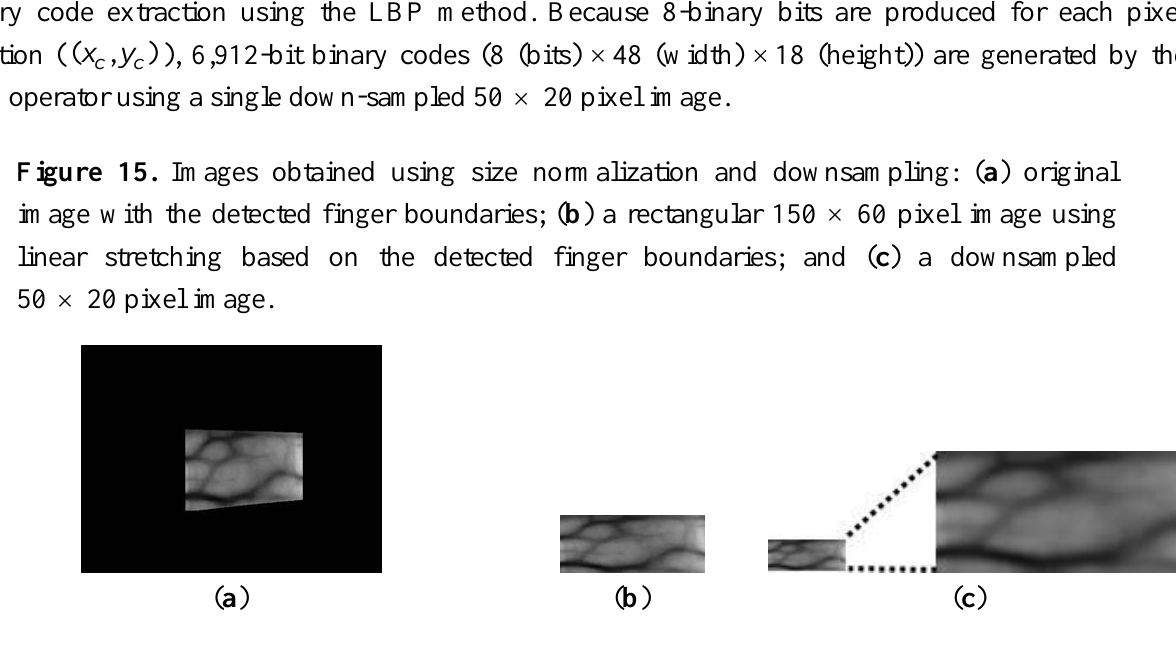
Figure 16. Example of finger-vein code extraction using a LBP